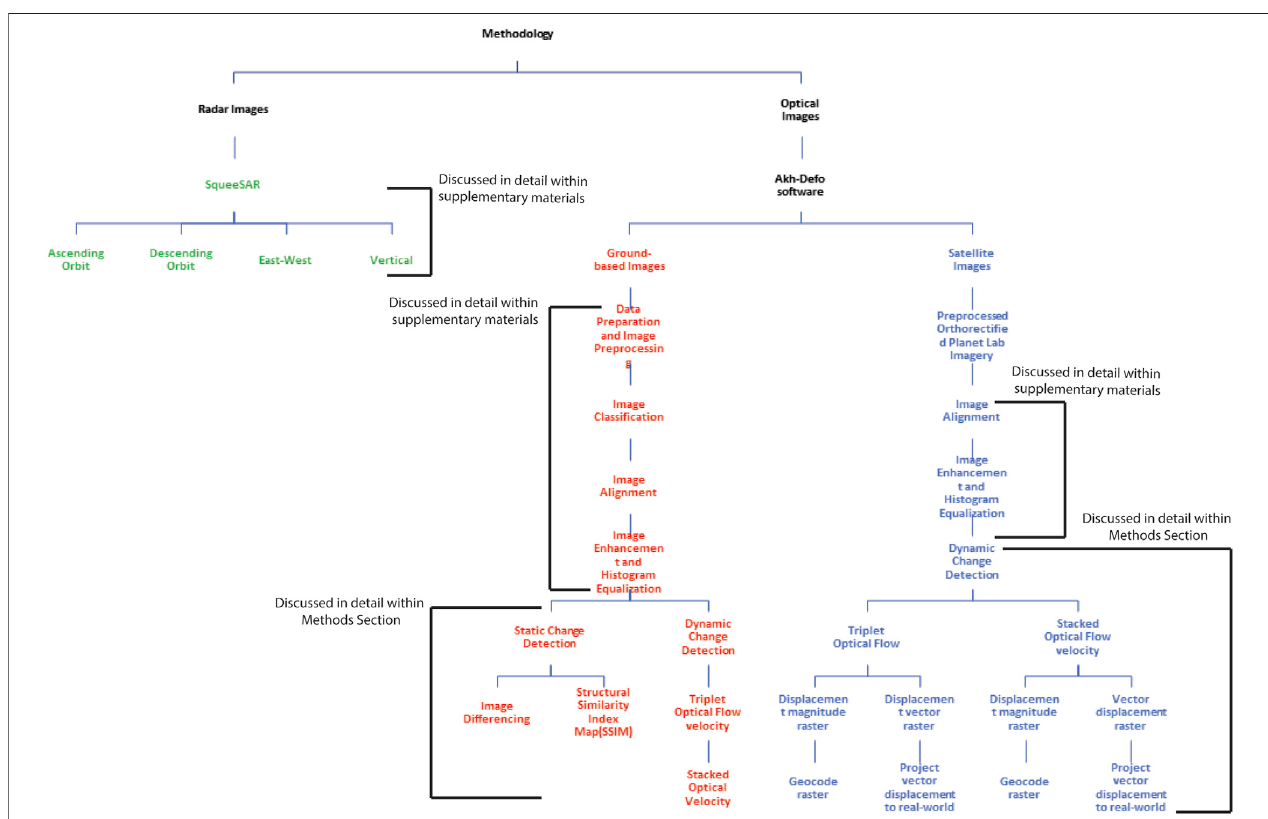
FIGURE 3 | Methodology fl ow chart showing the sequential data processing and analysis in this study.